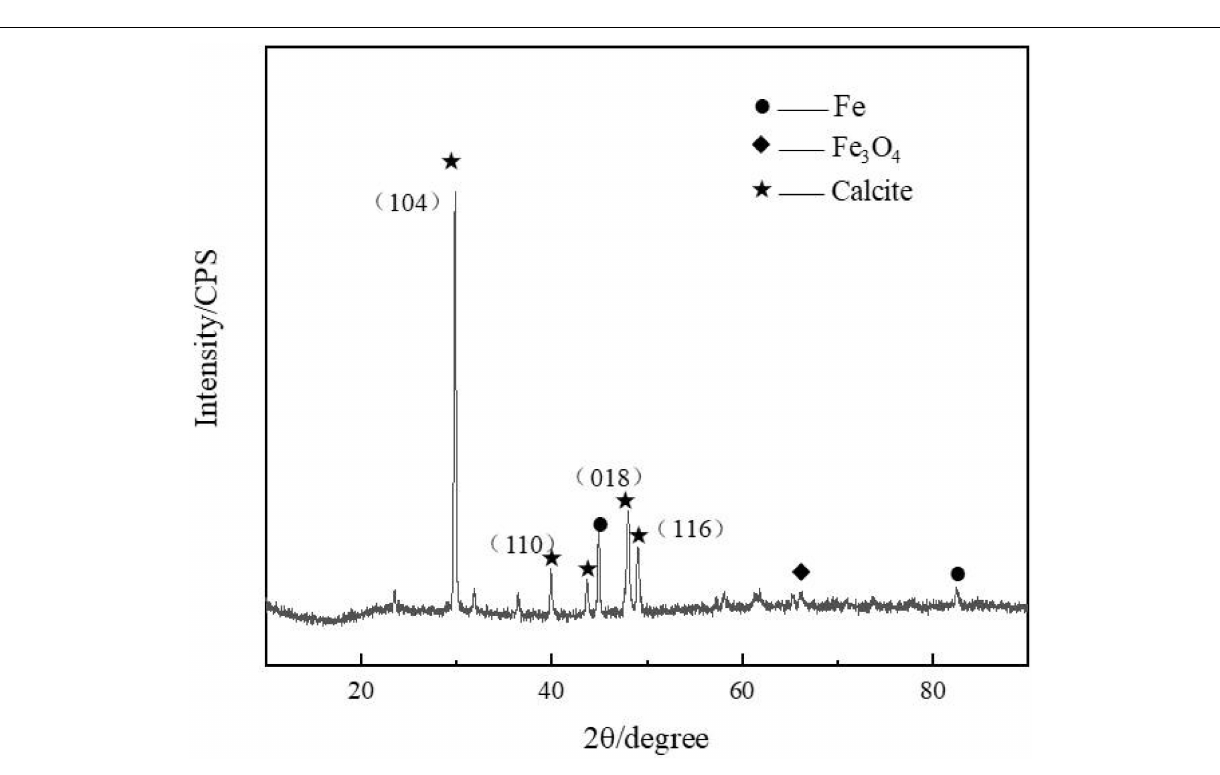
Frontiers in Microbiology |